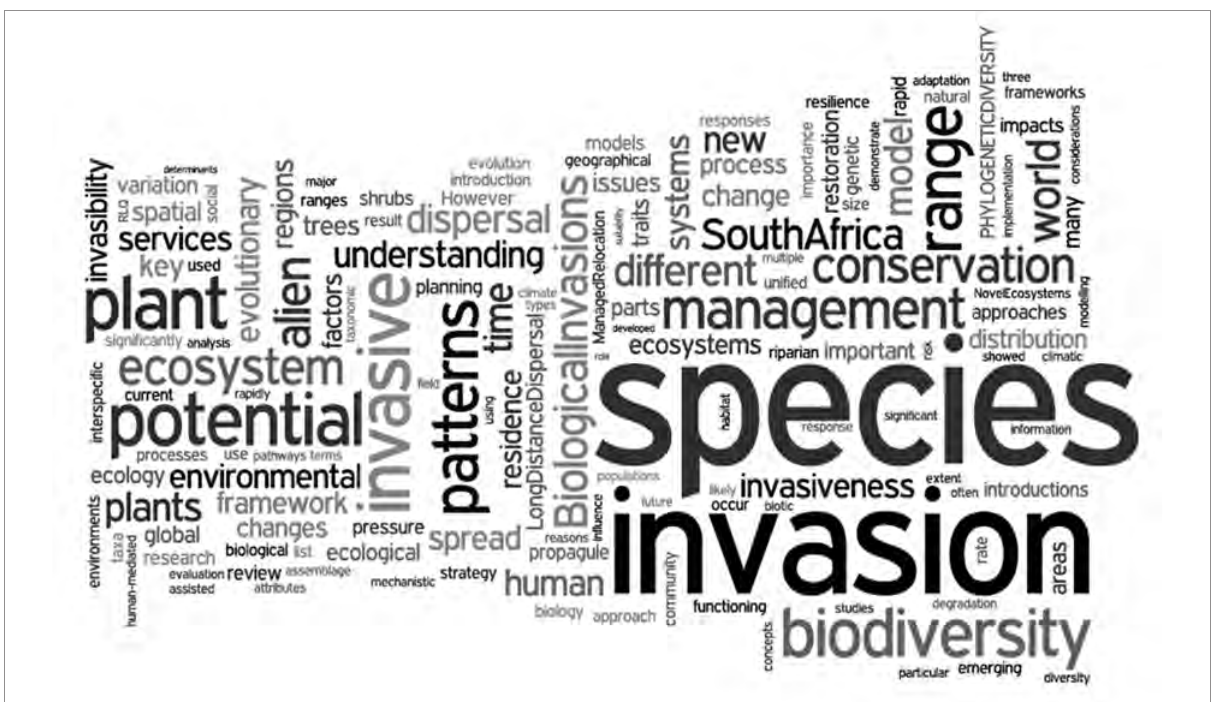
Figure 4: Word cloud derived from the 20 most highly cited papers published by the Centre for Invasion Biology between 2004 and 2013. The size of words is proportional to the number of times they appear in the titles, keywords and abstracts of these papers.